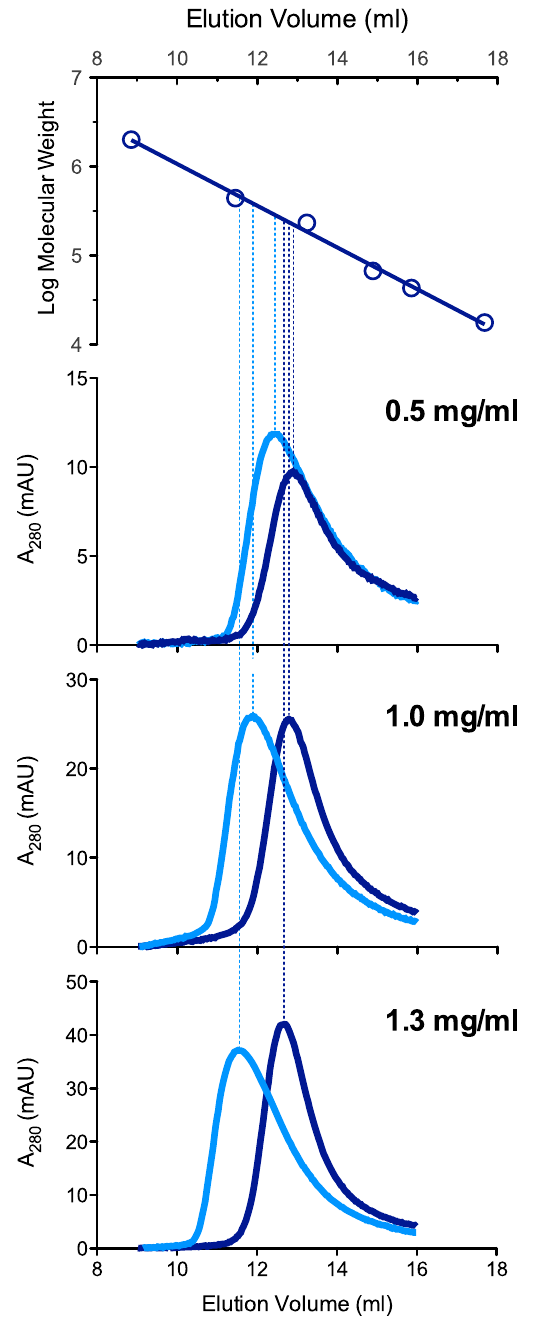
Figure 5. Analytical gel chromatography of zfNAGS-M with and without L-arginine. The top panel shows a semi-logarithmic plot of molecular mass vs. elution volume. Open circles correspond to elution volumes of blue dextran (2000 kDa), ferritin (440 kDa), catalase (232 kDa), aldolase (158 kDa), bovine serum albumin (66 kDa), ovalbu- min (43 kDa), and myoglobin (16 kDa). Lower panels show absorption at 280 nm as a function of elution volume. Concentration of zfNAGS-M loaded on the column is indicated in each panel. Dark blue – elution profiles of zfNAGS-M without arginine. Cyan – elution profiles of zfNAGS-M in the presence of 1 mM